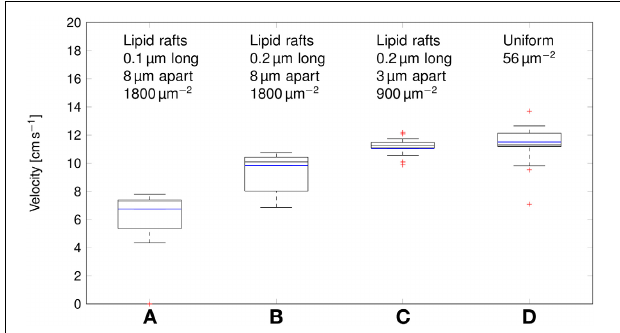
FIGURE 7 | Propagation velocity of action potentials for different channel distributions in a 0.1 µ m diameter C-fiber axon. Data was obtained using both deterministic (blue lines) and stochastic (boxes) simulations. (A) l = 0 . 1 µ m , L = 8 µ m, optimal values given by Zeng and Tang (2009), Na + channel density 1800 µ m − 2 , Note that in stochastic simulations some APs failed to propagate. (B) l = 0 . 2 µ m , L = 8 µ m, Na + channel density 1800 µ m − 2 , (C) l = 0 . 2 µ m , L = 3 µ m, Na + channel density 900 µ m − 2 , based on data on lipid raft placement given by Pristerà et al. (2012) and personal communication with Amber Finn. (D) Uniform distribution. On each box, the central mark is the median, the edges of the box are the 25th and 75th percentiles, the whiskers extend to the most extreme data points not considered outliers, and outliers are plotted individually.